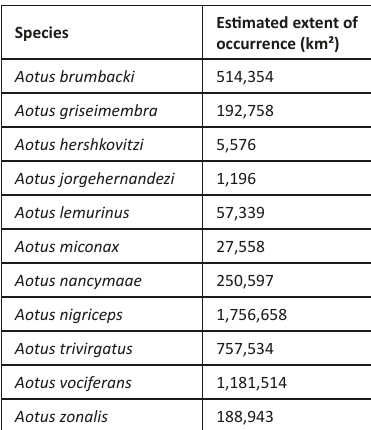
Table 2. Selected bioclimatic variables used in ecological niche analysis